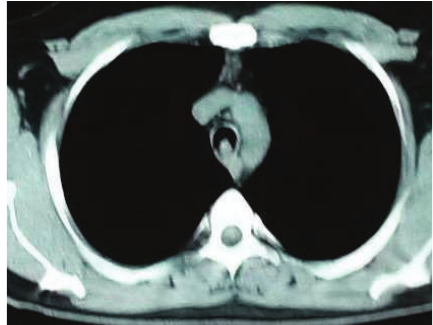
Figure 2: Chest CT showed a lesion protruding to the lumen in distal trachea at the posterior wall.